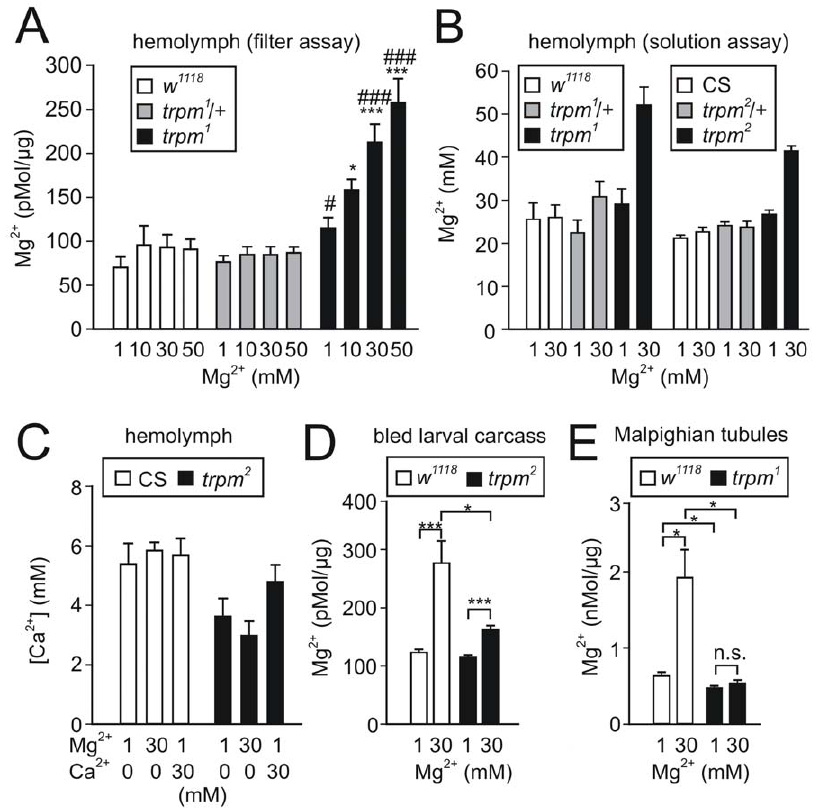
Figure 3. Hypermagnesemia due high dietary Mg 2 + . The quantification of Mg 2 + and Ca 2 + concentrations were determined after exposing early 3 rd instar stage larvae to the indicated concentrations of dietary Mg 2 + for 24 h. (A) Mg 2 + content in hemolymph from individual larvae exsanguinated on Whatman 3 MM paper. The Mg 2 + content was normalized to the protein content of the larval carcass. (B) Mg 2 + concentration in hemolymph collected into capillary tubes. Each sample tested consisted of hemolymph pooled from 8–10 larvae each from the indicated genotypes (left set of data, n=3 pools each; right set of data, n=5 pools each). CS, Canton S strain of wlld-type flies. (C) Hemolymph Ca 2 + concentrations determined using arsenazo III. The assays were performed with the same hemolymph pools from right set of panel (B). (D) Mg 2 + retained in the bled carcasses of trpm 2 larvae. (E) Mg 2 + in the Malpighian tubules. The levels of Mg 2 + were normalized to the protein content. Both pairs of Malpighian tubules, with a small portion of gut remaining were microdissected, homogenized and subjected to Mg 2 + determination and protein quantification (n=24 2 27 tubule sets each). Error bars represent SEMs.